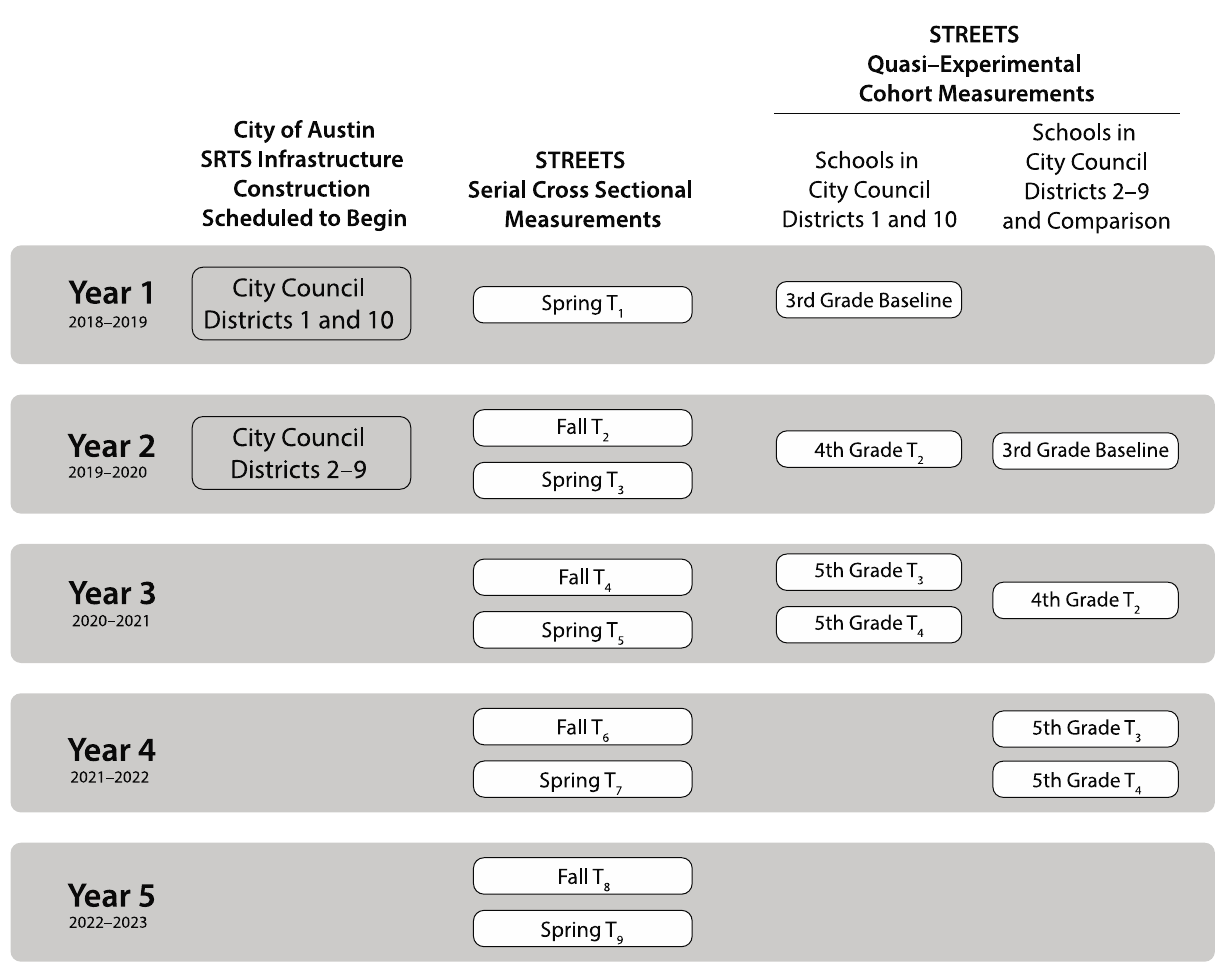
Figure 1. The Safe TRavel Environment Evaluation in Texas Schools (STREETS) Study Design and Measurement Schedule .